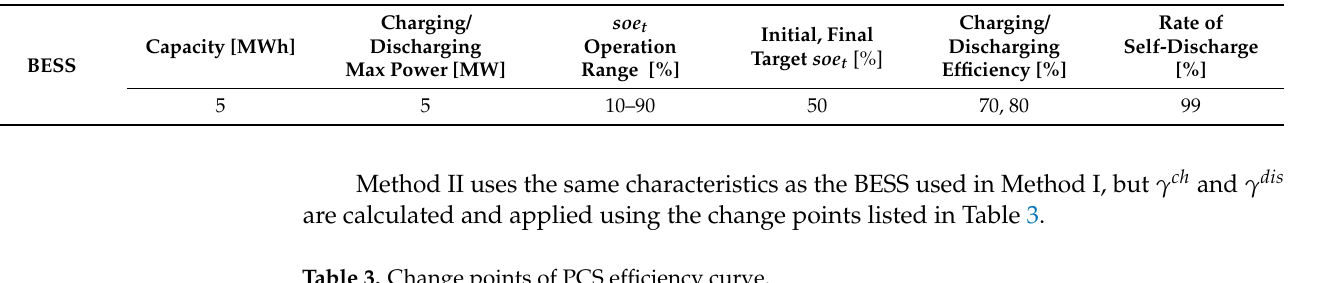
Table 3. Change points of PCS efficiency